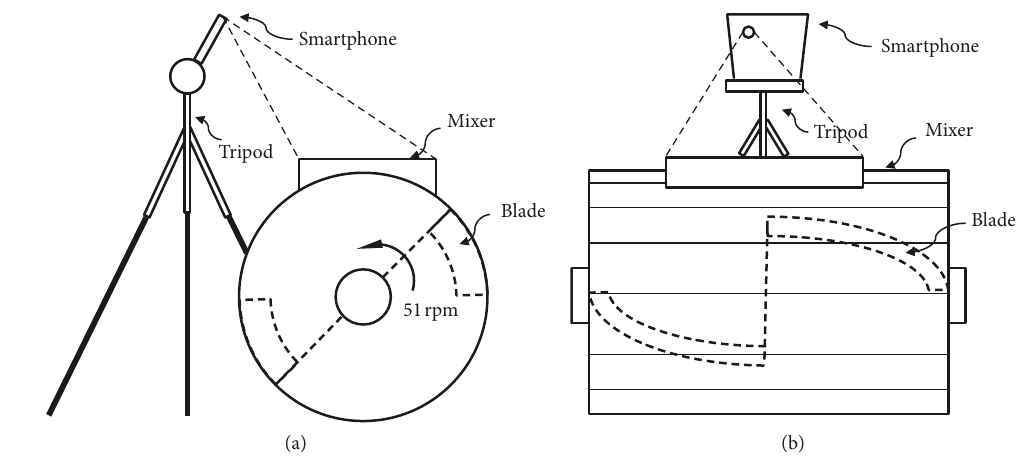
Figure 1: Schematic diagram of the apparatus: (a) side view; (b) front view.